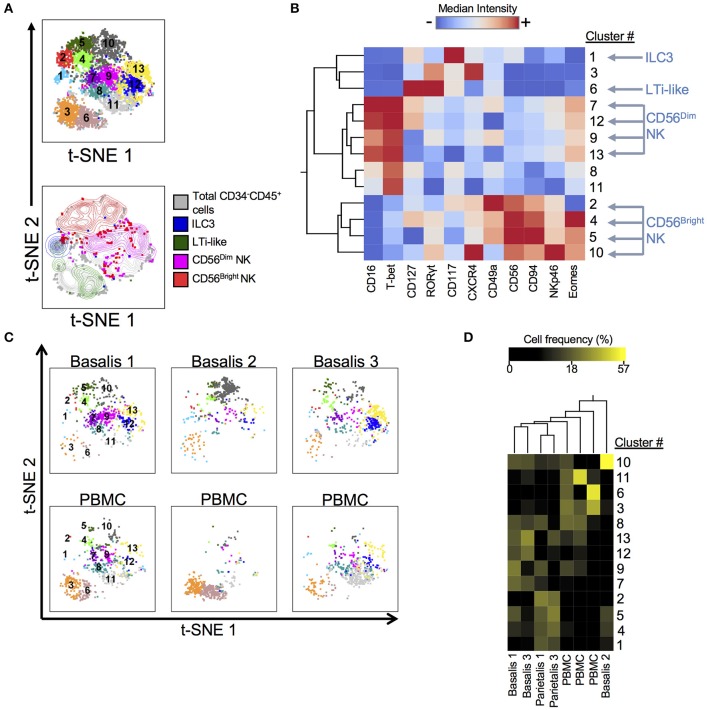
Subset Visualization of Innate Lymphocytes at Human Decidua Basalis. t-SNE was performed on CD34−CD45+Lin− cells from three experiments. Lin consists of CD3, CD14, and CD19. (A) t-SNE map generated from merged data from 3 experiments (top) and indicated cell subsets were manually gated and overlaid onto total CD34−CD45+Lin− cells (bottom). (B) Heatmap shows hierarchical clustering of median surface and intracellular marker expression levels of clusters identified by DensVM. Scale values indicate expression from low (blue) to high (red). (C) Separate decidua basalis and PBMC visualized using t-SNE map generated from the merged data set. (D) Heatmap shows hierarchical clustering of cluster frequencies within CD34−CD45+Lin− cells from decidua basalis (D.B), decidua parietalis (D.P), and PBMC (P). Scale values indicate cell frequency from low (black) to high (yellow).